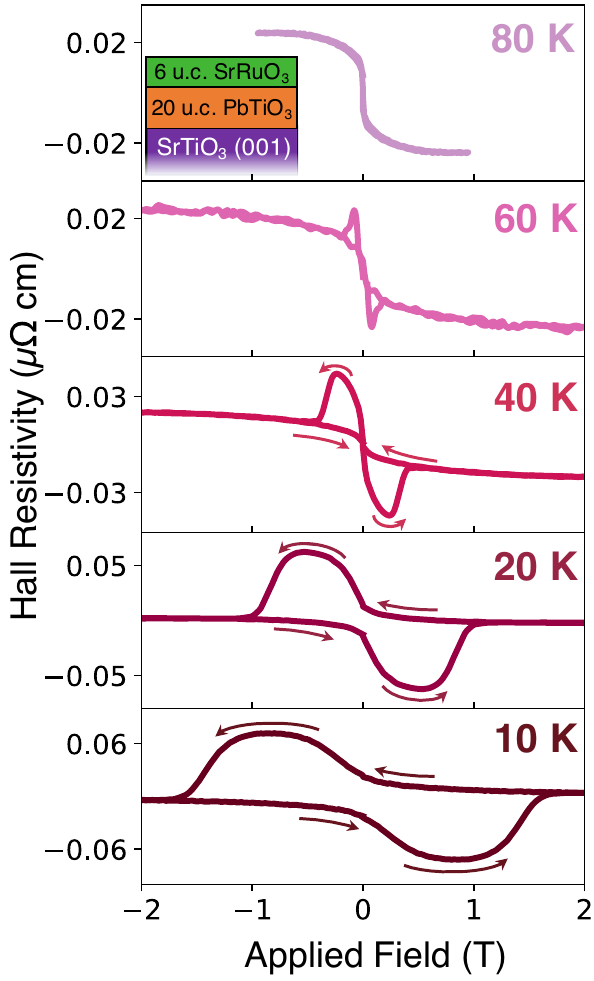
Fig. 1 Temperature evolution of Hall measurements. Emergence of a topological-like Hall response below 80 K in SRO – PTO – STO heterostructures. The linear Hall contribution was subtracted. Field-sweep directions are indicated by the arrows. Inset shows the schematic of the